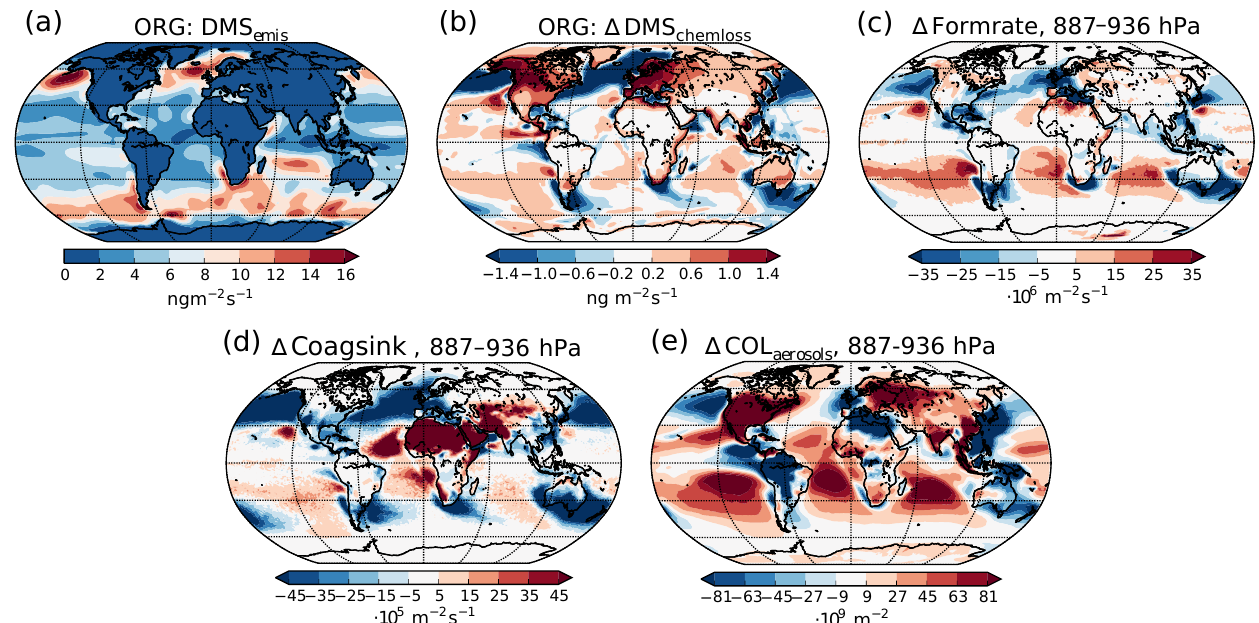
Figure 6. (a) Emission rate of DMS (same for both PI simulations). (b) Difference in net chemical loss of DMS though oxidation. (c) Differ- ence in aerosol formation rate in the 887–936hPa layer. (d) Difference in the coagulation sink during nucleation in the 887–936hPa layer. (e) Difference in column burden of aerosols in the 887–936hPa layer. All differences show values from the PI simulation using PI oxidants minus values from the PI simulation using PD